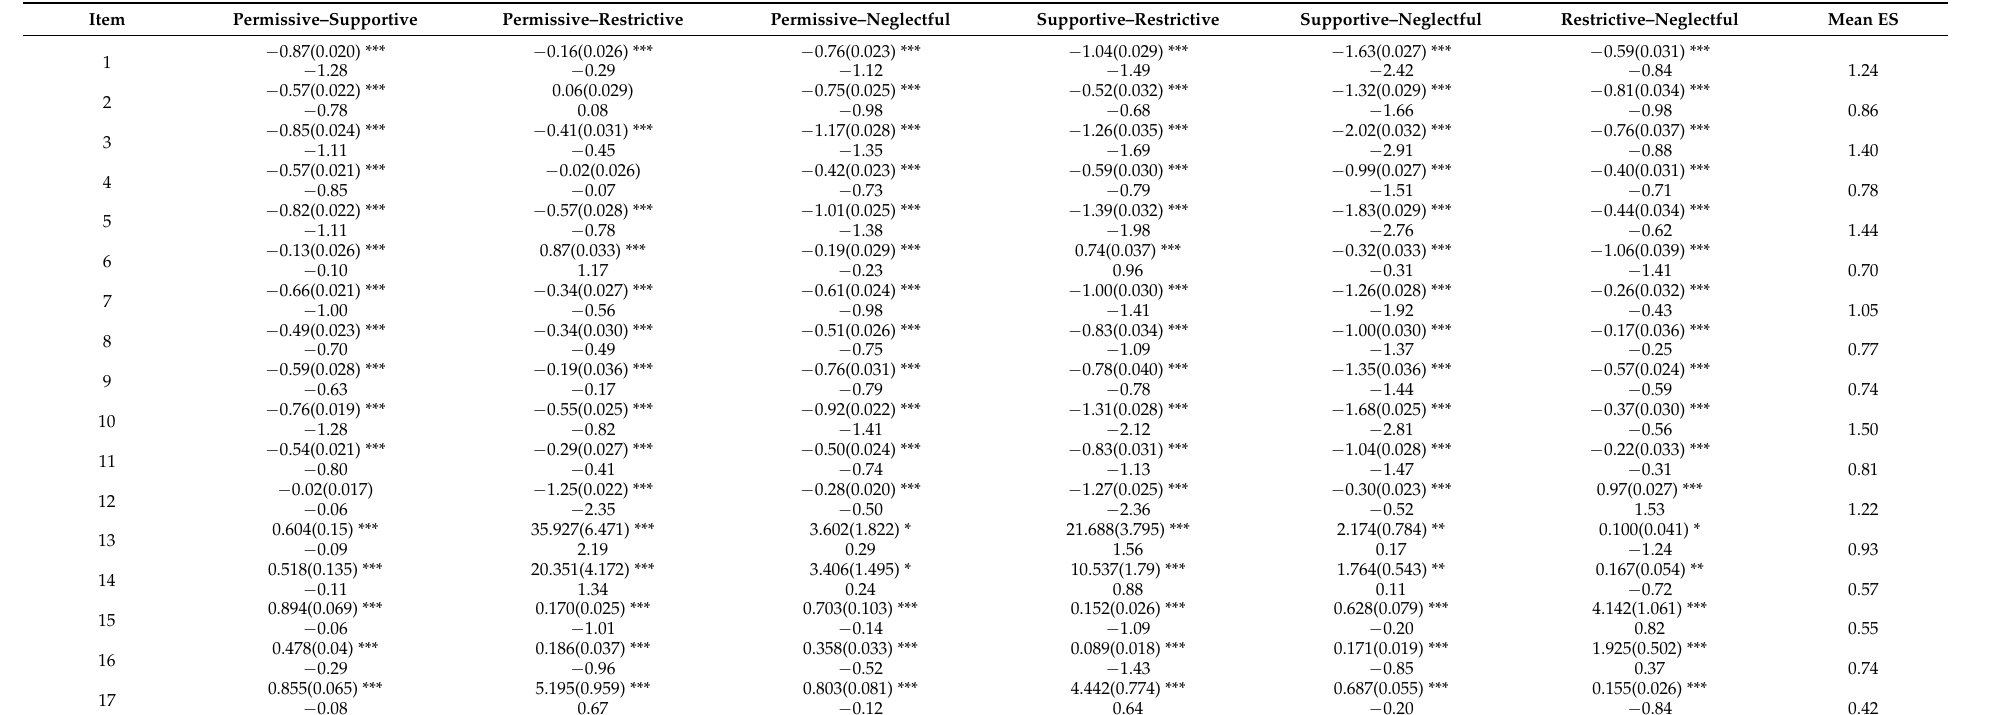
Table A2. Mean differences, standard errors, and effect sizes for group pairs.